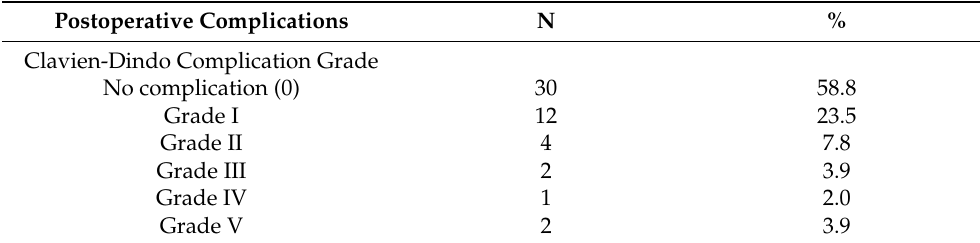
Table 3. Frequency of complications by Clavien-Dindo